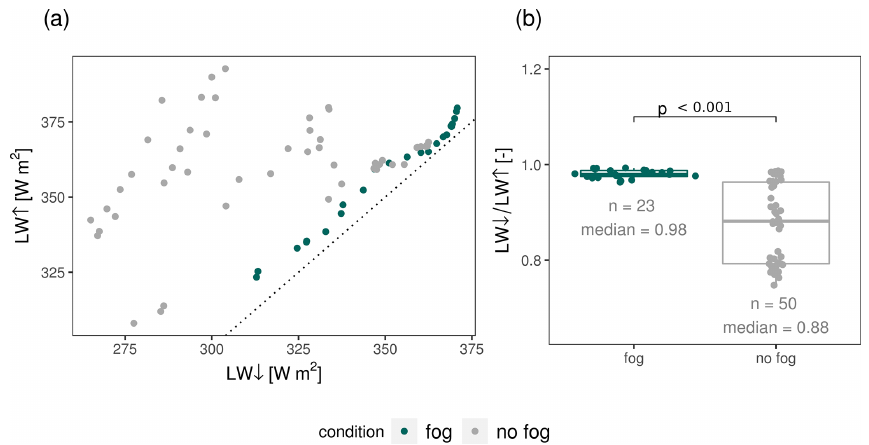
Figure G2. Comparison of LW upwelling ( ↑ ) and LW downwelling ( ↓ ) during the conditions classified as having fog and without fog from a digital camera (example pictures shown in Fig. G1). The black dotted line in panel (a) displays the identity line. Panel (b) illustrates the radiation ratios during foggy and non-foggy conditions. The differences between the ratios are statistically significant, with a significance level of p < 0 . 001.